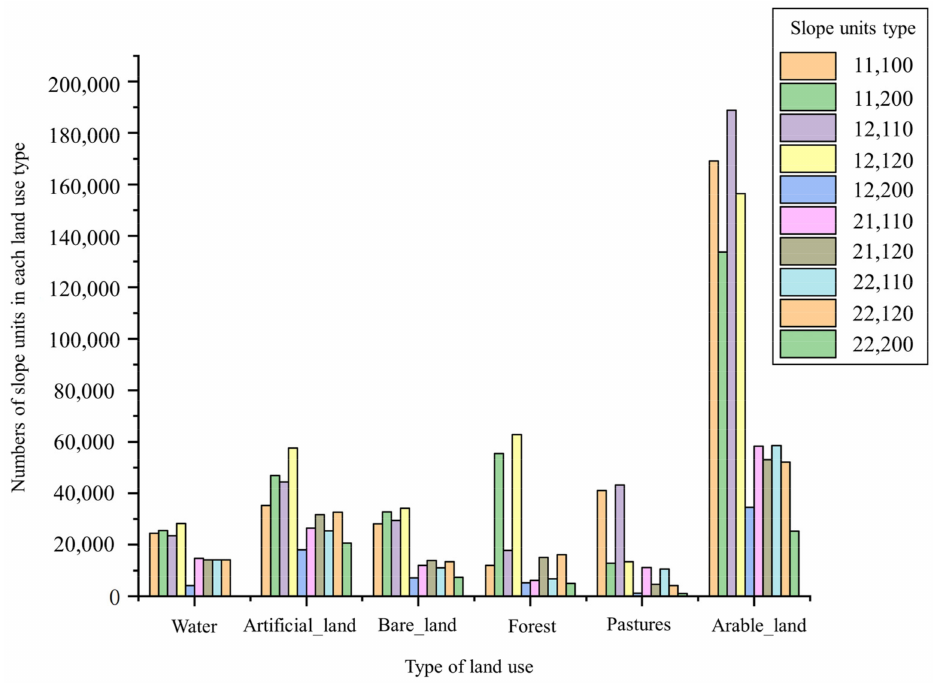
Figure 12. Histogram of the number of slope units in each land use in the Lushan